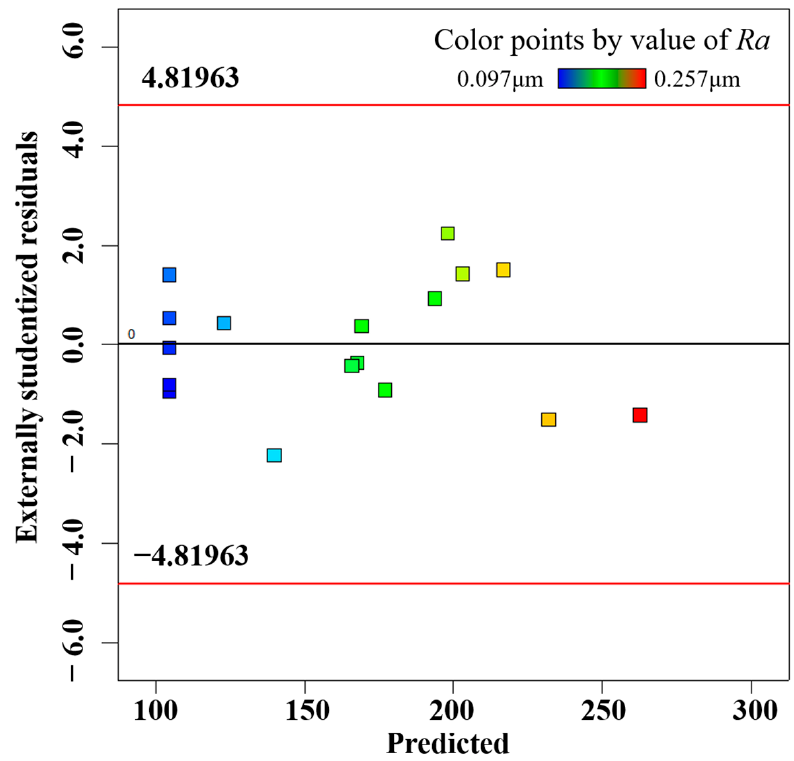
Figure 6. Residuals versus predicted plot.